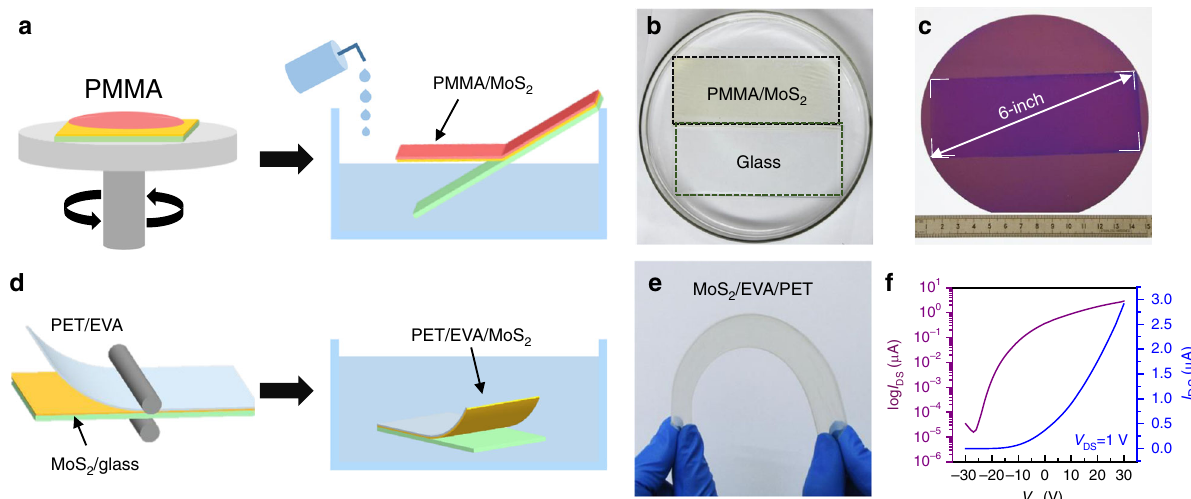
Fig. 5 Green transfer process and device performance of monolayer MoS 2 . a Schematic diagram of the PMMA-assisted etching-free transfer process onto rigid substrates. b Photograph of the delamination process for removing the PMMA/MoS 2 fi lm from the glass substrate. c Photograph of the 6-inch MoS 2 fi lm transferred onto a SiO fl exible substrates. e Photograph of a typical 6-inch 2 /Si substrate. d Schematic diagram of the roll-to-roll transfer route onto uniform, fl exible, monolayer MoS 2 /EVA/PET stack. f I DS – V G curves of a typical MoS 2 FET device at V DS = 1